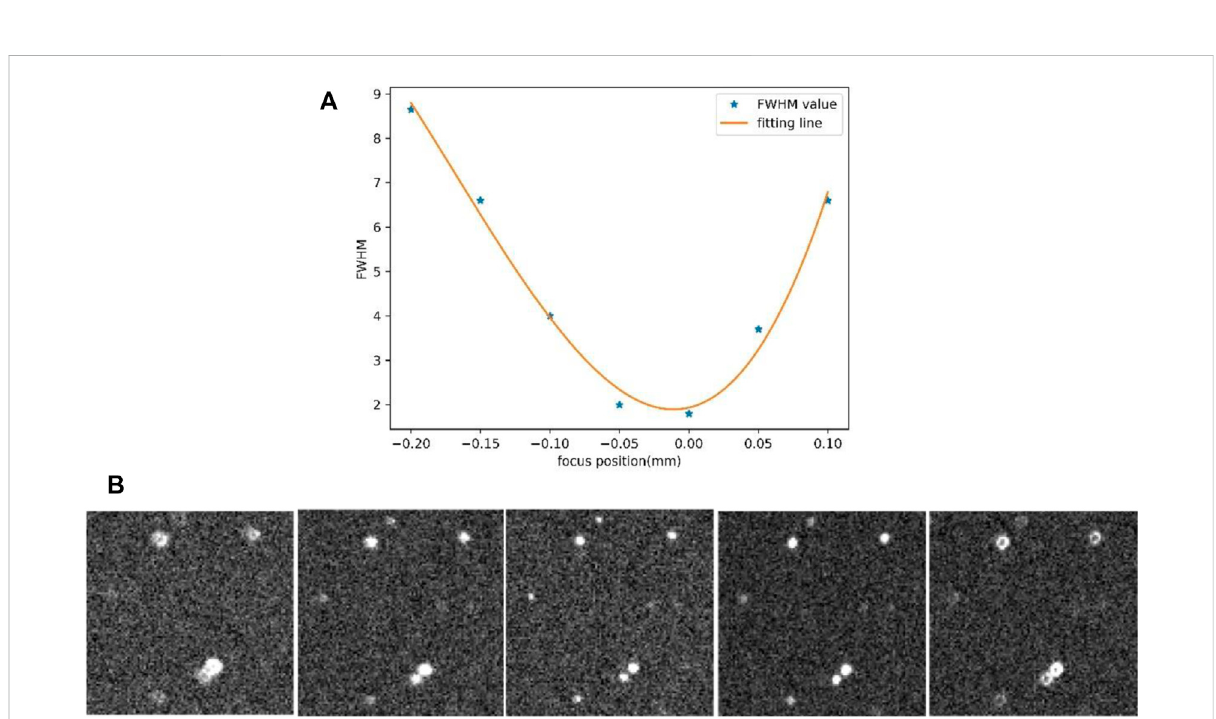
FIGURE 8 The change of the limiting magnitude (tracking star mode) witha10 sexposure timeofthe36 cmtelescopeinamonth (from 2 December 2021 to 3 January 2022). Every night, the same sky area was selected to take images from 10:00 p.m. to 11: 00 p.m., and the limit magnitude of each day was calculated, which is represented by an asterisk in the fi gure.